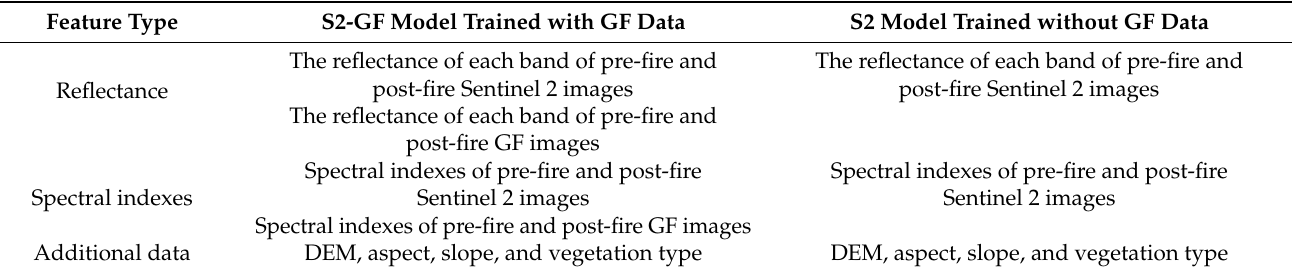
Table 5. Features used in the models to identify fire